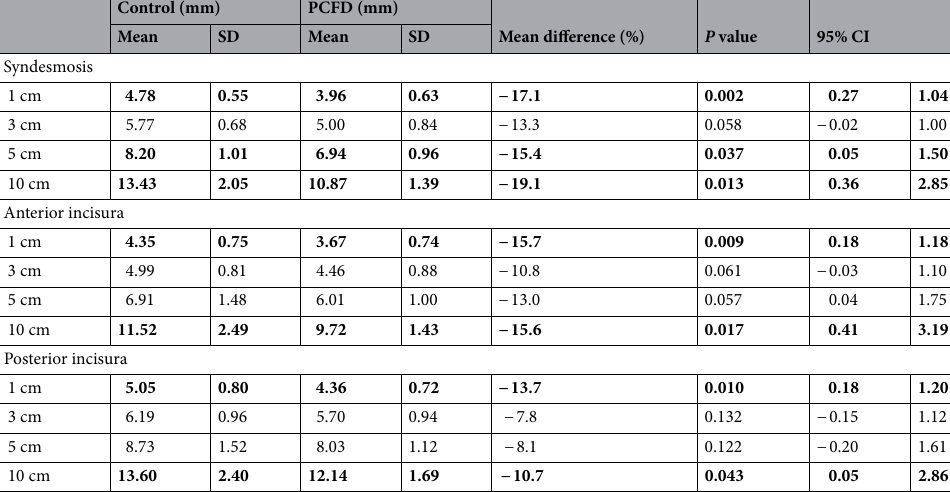
Table 3. Means and Standard Deviations for Syndesmotic Distances Measured in Millimeters, and Mean Difference in Distances from Control to Progressive Collapsing Foot Deformity Patients with P Values and 95% Confidence Intervals for Comparisons. Bolded rows denote significant changes within the region. PCFD progressive collapsing foot deformity, MD mean difference, SD standard deviation, cm centimeter, mm millimeter, CI confidence interval. *Statistically significant ( p <